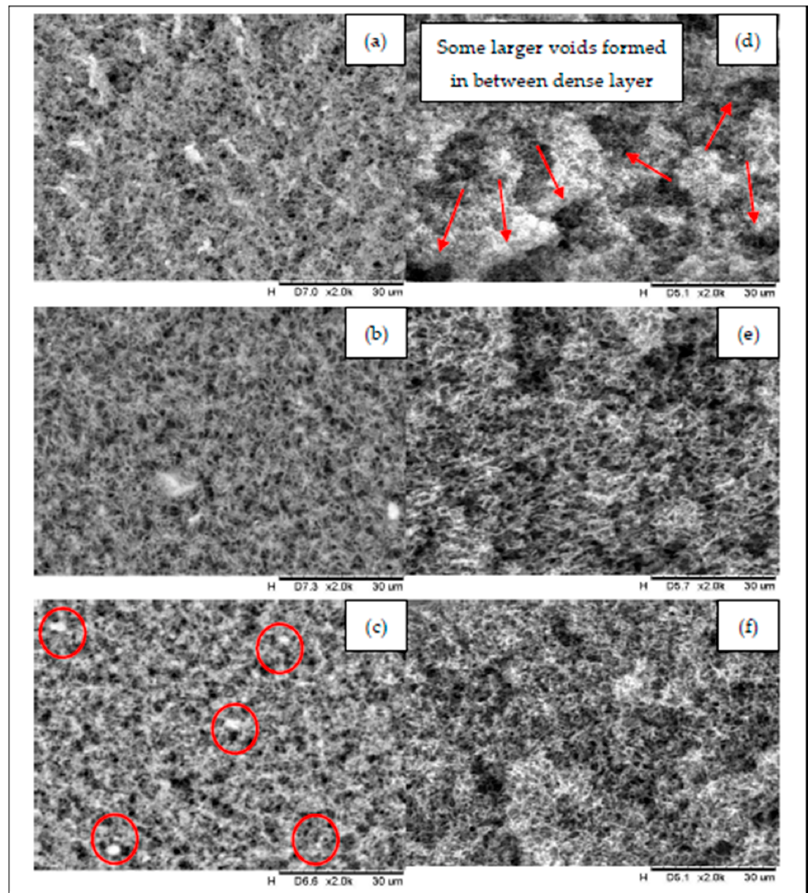
Figure 2. Comparison of surface (left) and cross section (right) of the prepared membranes before and after the addition of functionalized halloysite nanotube (HNTs); ( a , d ) PVDF, ( b , e ) Pf s -HNT and ( c , f ) Pf w -HNT.